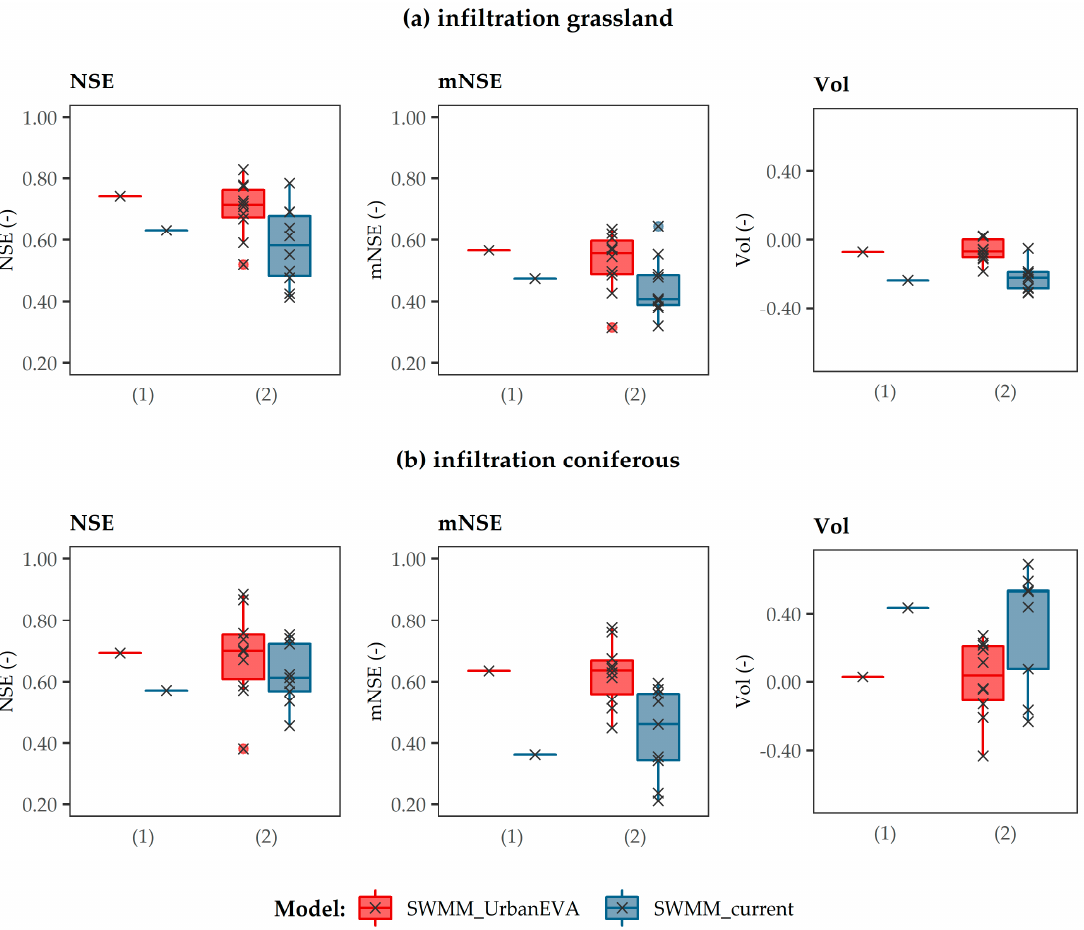
Figure 6. Results of SCEUA automatic calibration: Performance criteria of best-fit parameter set for calibration periods (1) total calibration period 1989 – 1999 and (2) years within 1989 to 1999. Calculation for modelled infiltration of ( a ) grassland and ( b ) coniferous.